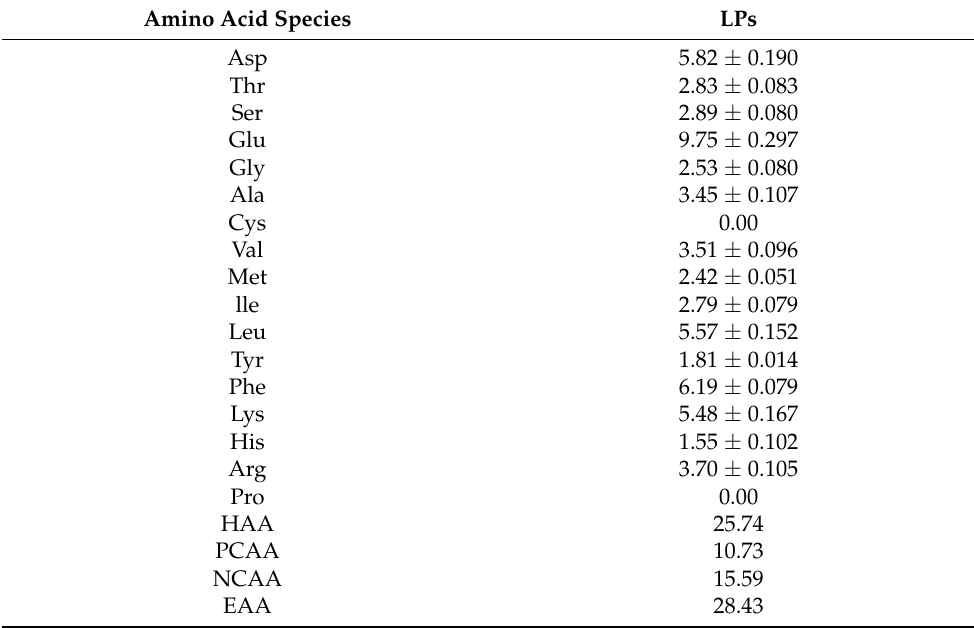
Table 1. LP composition (g/100 g) in amino acids.